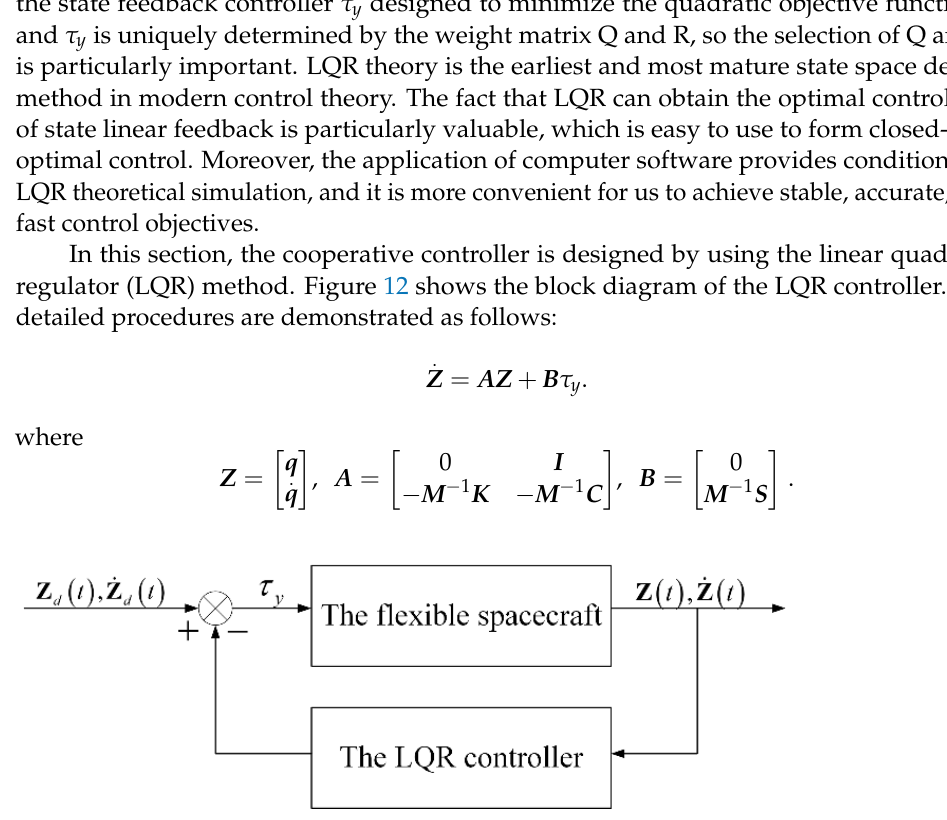
Figure 12. Block diagram of the LQR controller.